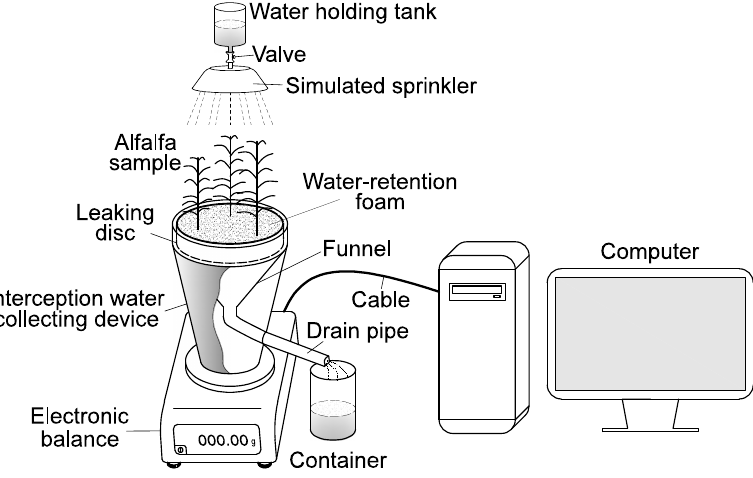
Figure 2. Schematic of the experimental system for measuring canopy interception during simulated